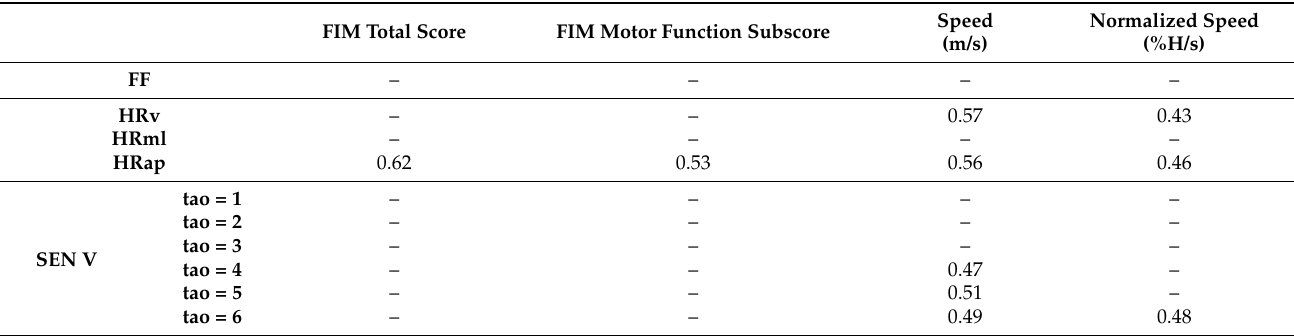
Table 6. Spearman correlation coefficients ρ for indices and (i) FIM total score and (ii) FIM motor function subscore; (iii) walking speed and (iv) normalized walking speed. FIM Total Score FIM Motor Function Subscore